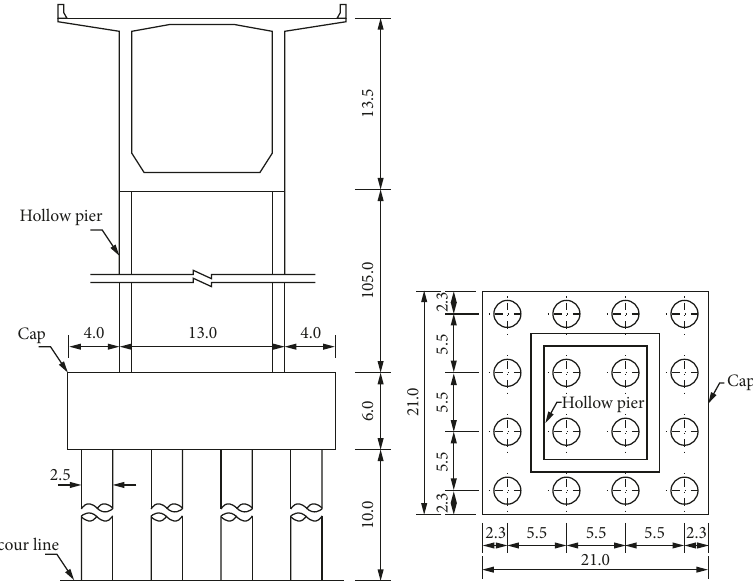
Figure 2: Dimensions of the prototype hollow pier; all dimensions are in